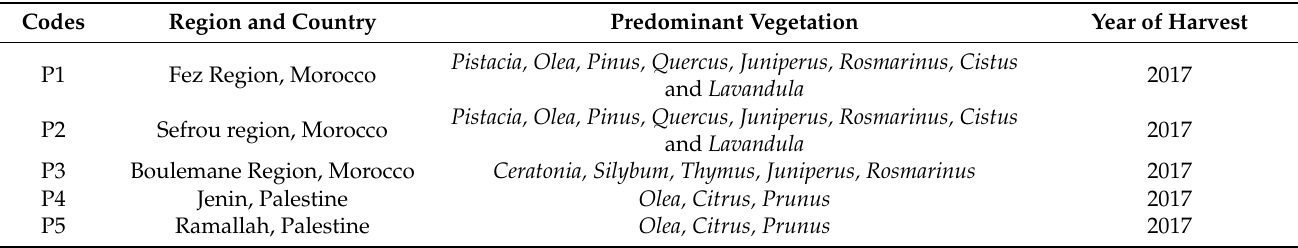
Table 8. Region and Country of propolis samples collected with predominant